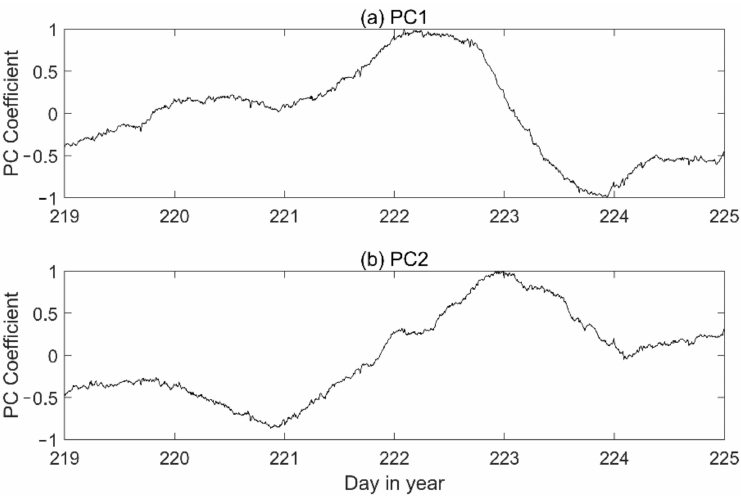
Figure 6. Two leading PC time series of the PWV